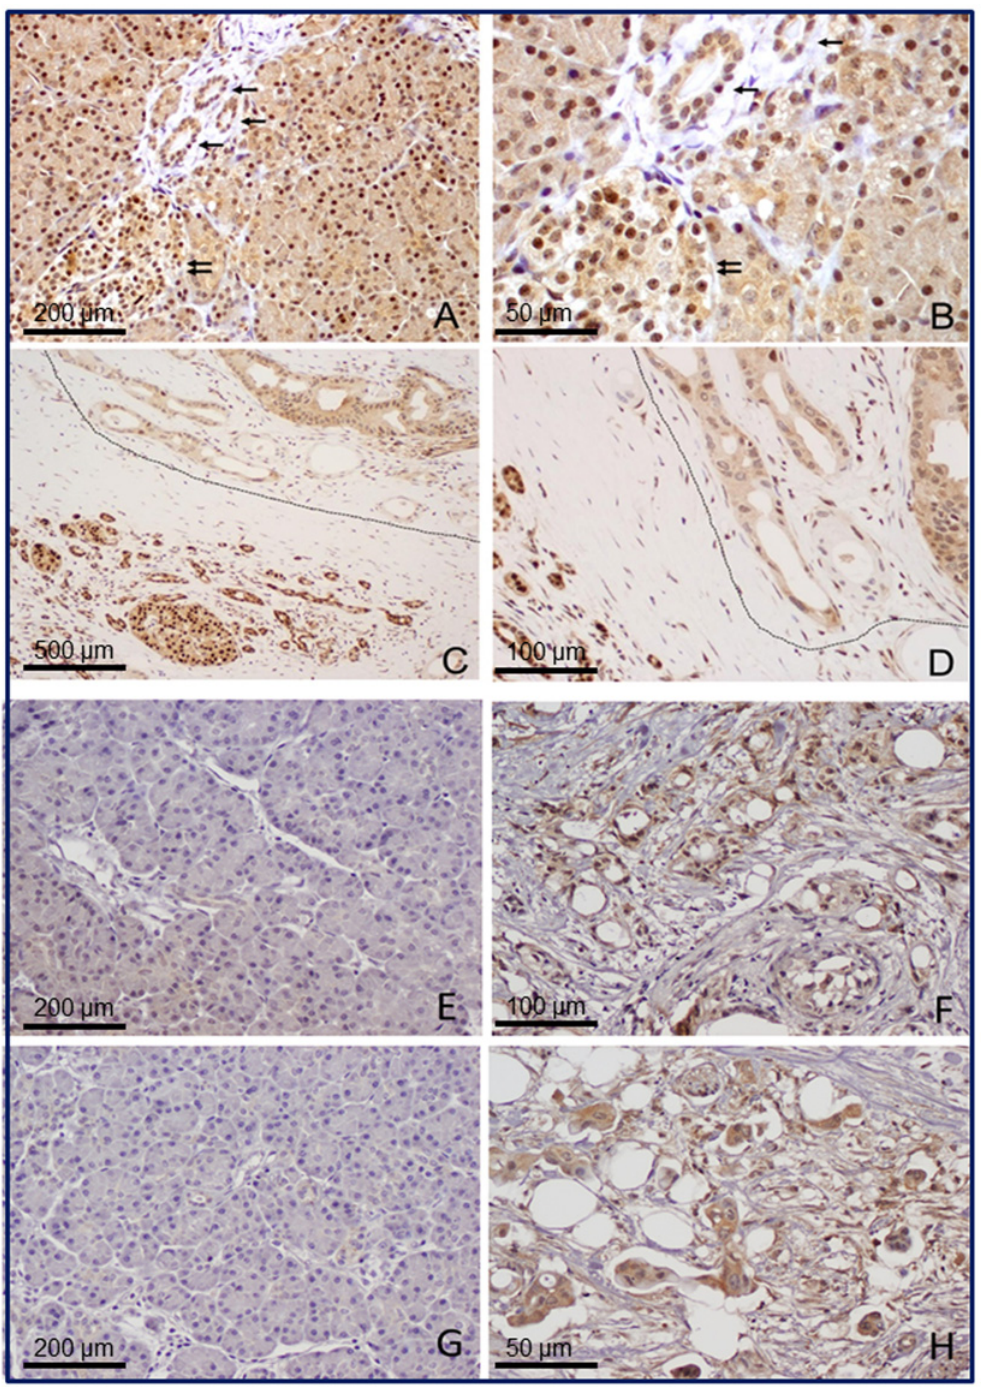
Fig 2. Representative micrographs of HNF1A, pAKT, pmTOR in PDAC cancerous tissue or its surrounding non-tumor tissue by immunohistochemistry. Images (A and B) show cytoplasmic and nuclear expression of HNF1A in normal pancreatic tissue. The normal pancreatic ducts are marked with single arrow. Islet cells are marked with double arrows. Pancreatic islet cells have higher level of HNF1A expression than acinar and ductal cells. Images (C and D) show the expression of HNF1A in pancreatic ductal adenocarcinoma (circled) and benign pancreatic ductal cells and islet cells adjacent to the tumor (left). Panel E-H show the representative micrographs for p-AKT (E and F) and p-mTOR (G and H) expression in normal pancreatic tissues (E and G) and pancreatic ductal adenocarcinoma (F and H). Magnifications: 100X for A, E and G; 400X for B and H, 40X for C, 200X for D and F.